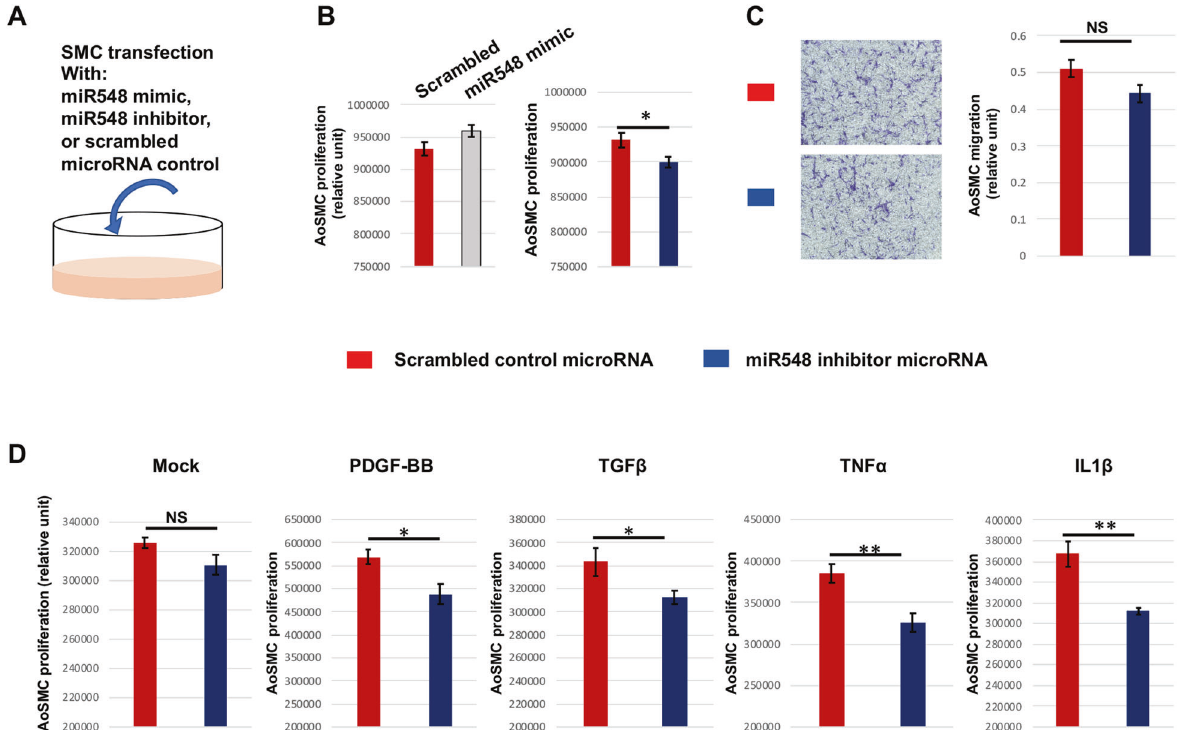
Fig. 6 Effect of miR548ai inhibitor on AoSMC proliferation and migration. A Schematic of the experimental design for this fi gure. B SMC proliferation in full medium. AoSMCs cultured in the full medium were transfected with miR548ai mimic or inhibitor or scrambled microRNA (control) prior to CellTiter-Glo assay. C SMC migration in full medium. AoSMCs cultured in the full medium were transfected with miR548ai inhibitor or scrambled microRNA (control) prior to the Transwell migration assay. D SMC proliferation in de fi ned medium. Starved AoSMCs were transfected with miR548ai inhibitor or scrambled control prior to stimulation with PDGF-BB, TGF β 1, TNF α , or IL1 β (same concentrations as indicated in Fig. 1). Data are presented as mean ± SD ( n = 3 replicates). Student t -test: * P < 0.05, ** P < 0.01; NS not signi fi